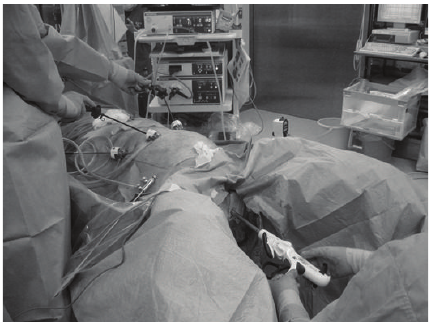
Figure 2: Intraoperative image showing the liner stapler being inserted into the abdominal cavity via the vaginal 12mm port inserted into the